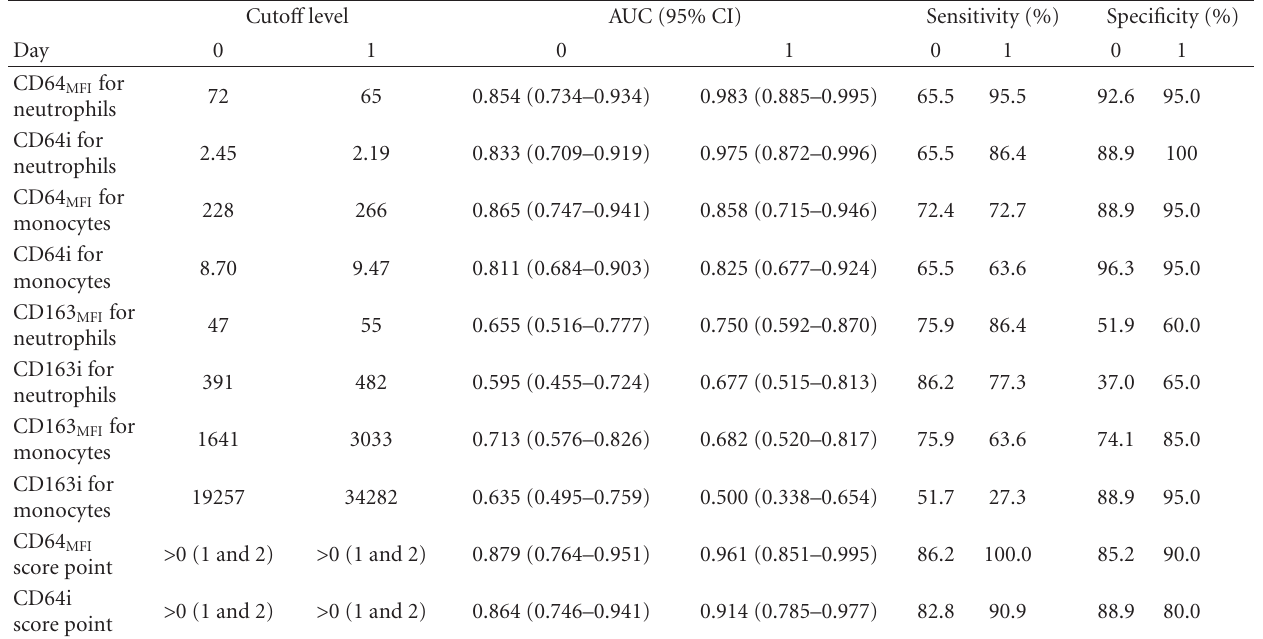
Table 3: Optimum diagnostic cuto ff level, diagnostic accuracy with 95% confidence interval (CI) determined by the area under the ROC curve (AUC), sensitivity, and specificity for given cuto ff levels of CD64 and CD163 MFI and indexes (i) for neutrophils and monocytes and CD64 score points for sepsis prediction in critically ill neonates and children at the time of suspected sepsis (day 0) and 24 hours later (day